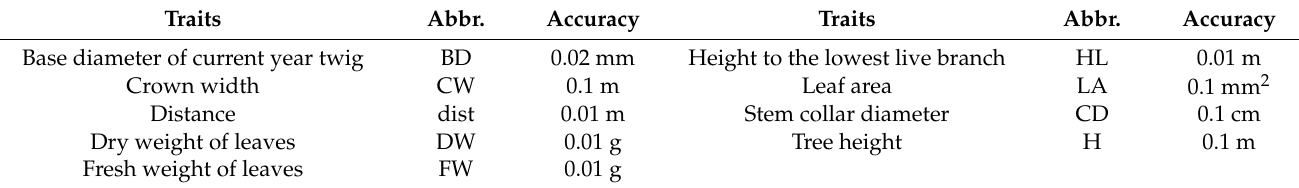
Table 1. Named abbreviation (Abbr.) and measurement accuracy of measured